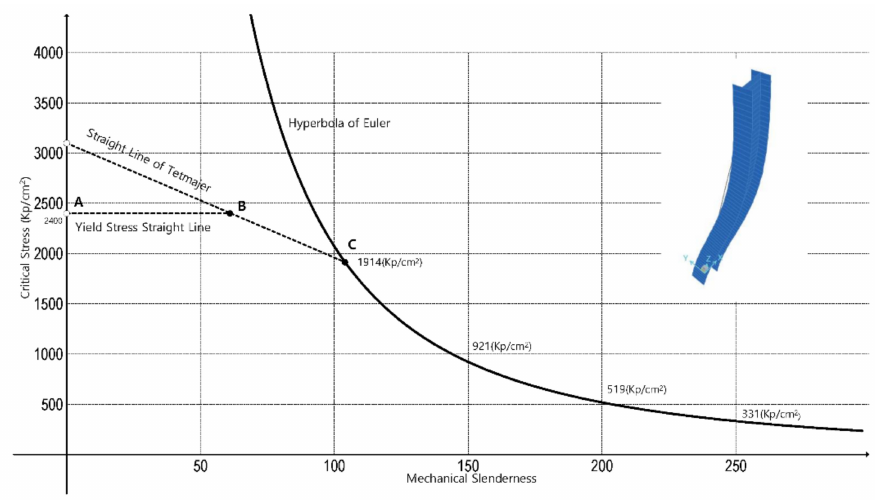
Figure 1. Basic diagram to show buckling of steel columns in the light of Euler’s equation, the yield stress of steel, and Tetmajer’s later